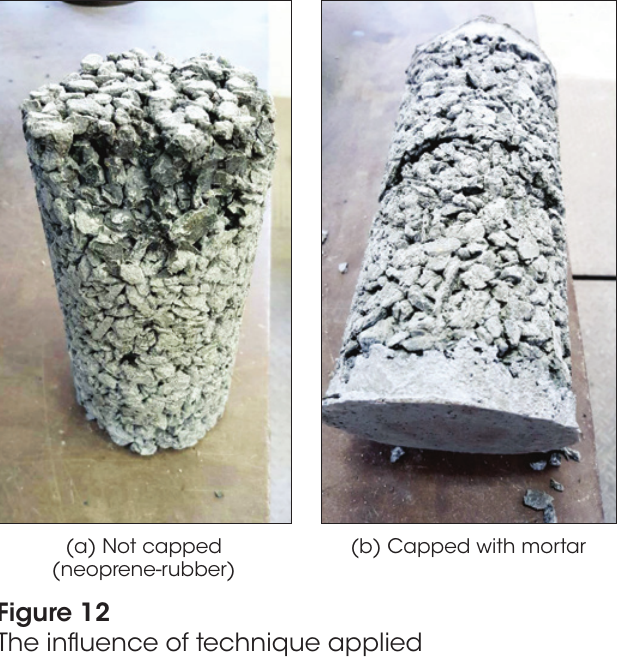
(a) Not capped The influence of technique applied to compressive test